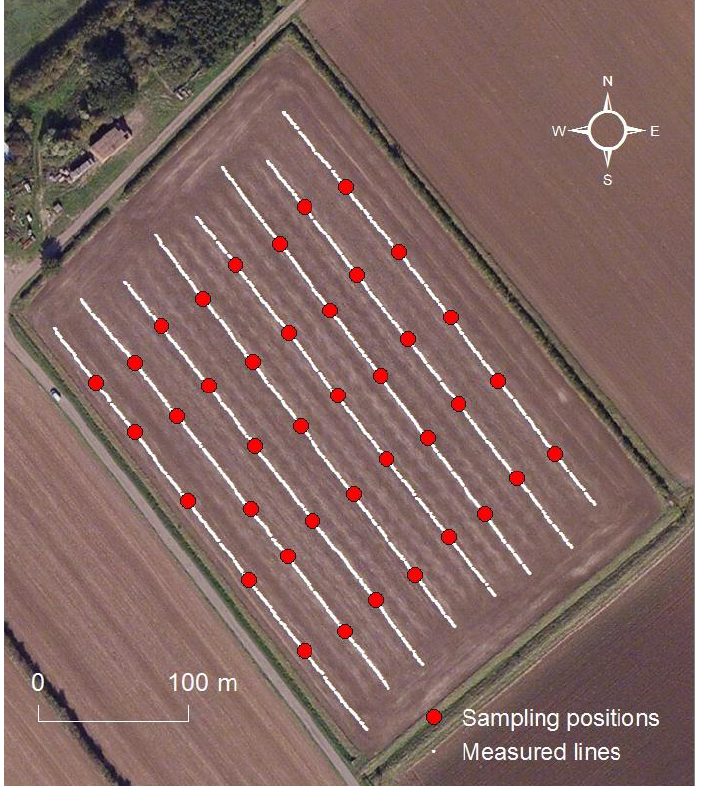
Figure 2. Measured lines with sampling positions, recorded with a DGPS.